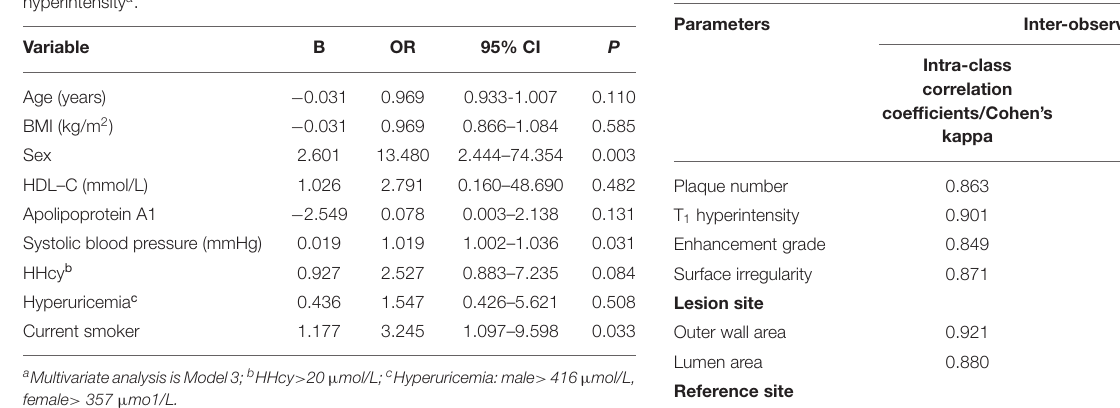
TABLE 5 | Inter-observer reproducibility ( N =